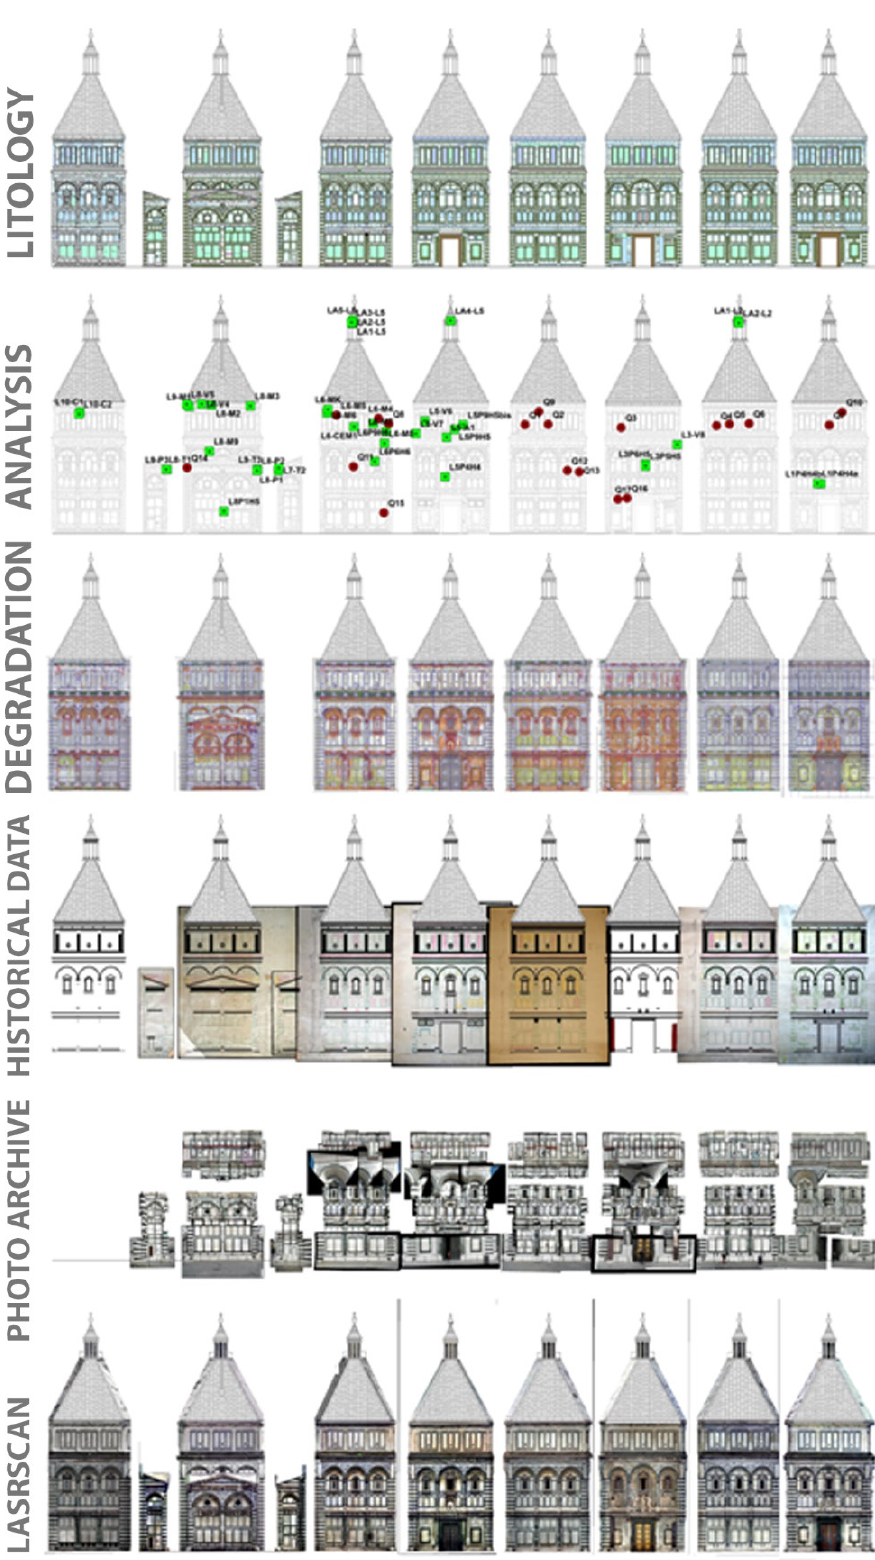
Figure 6. All GIS layer stored in Battistero di San Giovanni Figure 6 . All GIS layer stored in Battistero di San Giovanni project. Mobile side